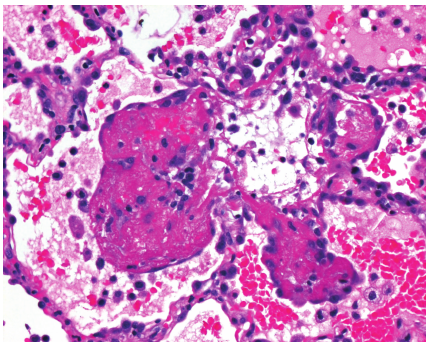
Figure 3: High power magnification of hematoxylin and eosin stained lung biopsy demonstrating a pauci-immune small vessel